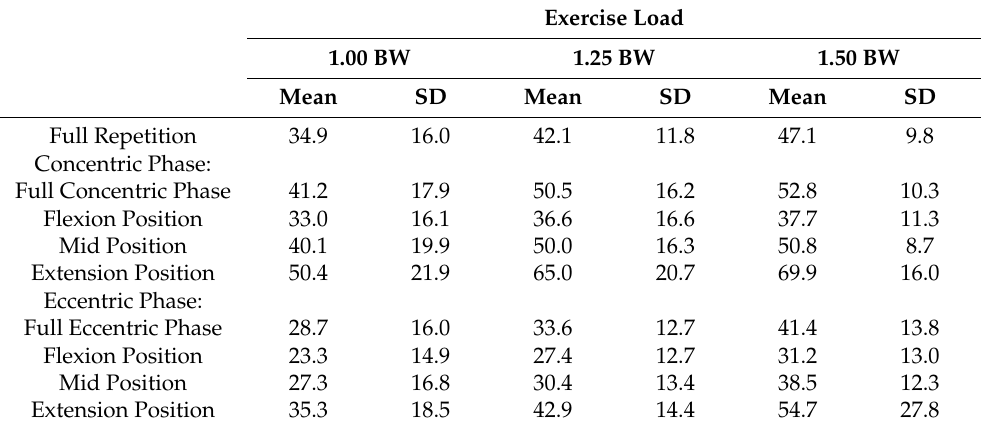
Table 2. Normalized lumbar extensor muscle surface EMG activity (in % MVIC) during dynamic exercise on a home back extension exercise device depicted by exercise load, phase of movement, and position in range of